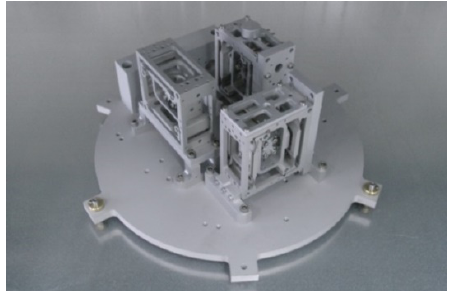
Figure 5. Triaxial sensor based on monolithic UNISA Folded Pendulum